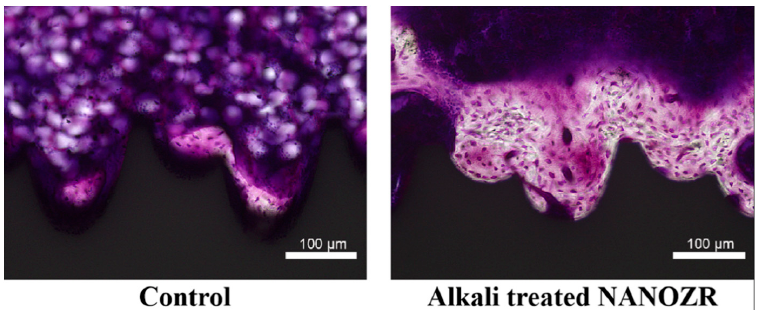
Figure 6. The longitudinally undecalcified histological sections with implants and peri-implant bones implant bones (purple: osteoid; white: new bone). (purple: osteoid; white: new bone). implant bones (purple: osteoid; white: new bone).